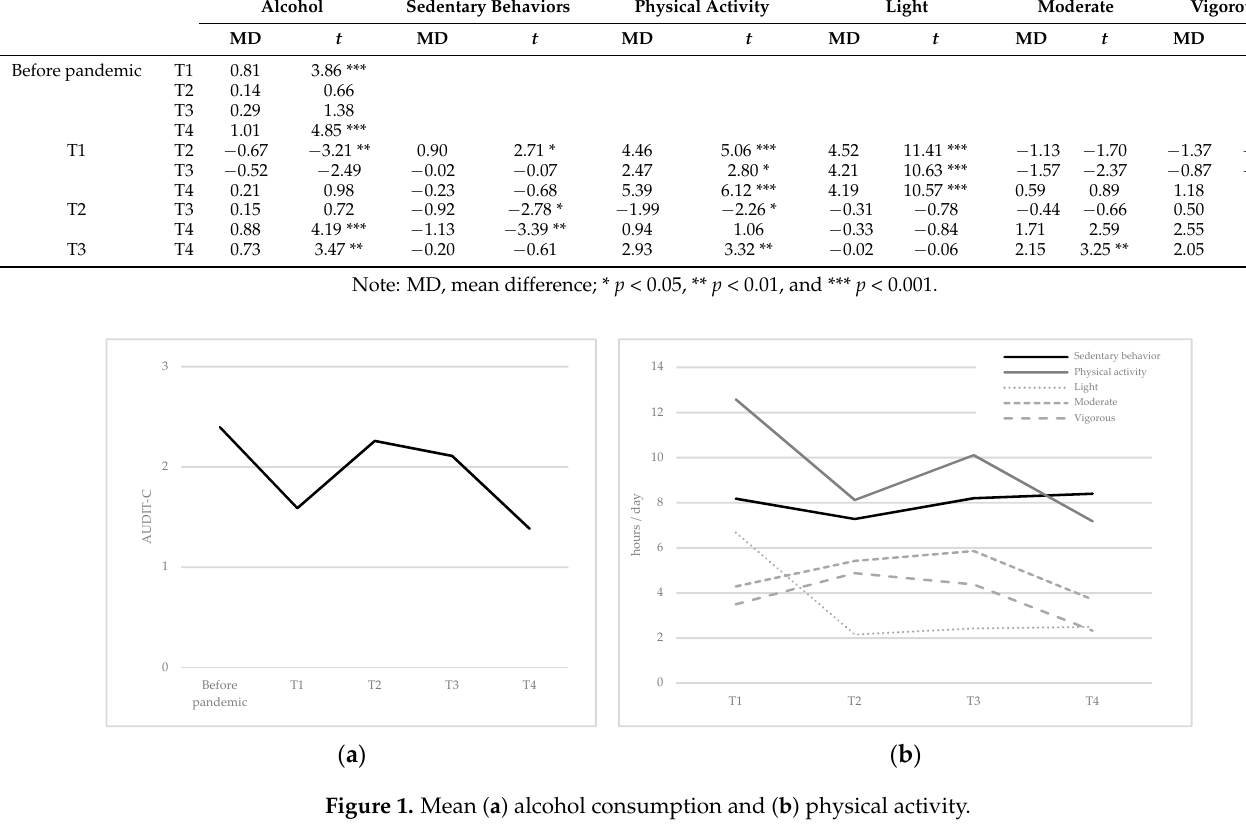
Table 3. Post-hoc comparison.